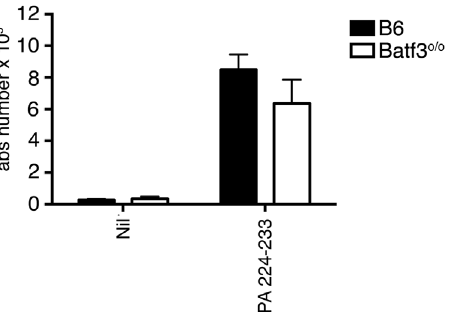
Figure 2. PA 224–33 T CD8 + can be generated in Batf3 o/o mice. B6 or Batf3 o/o mice were inoculated intraperitoneally with 2.5 6 10 6 LPS- treated, PA 224–233 peptide-pulsed B6 bone-marrow-derived DC. 7 days later, the number of PA 224–233 responding T CD8 + present in the spleen was determined by ICS. Average is taken from 6 mice per group over two independent experiments and the error shows the SEM.